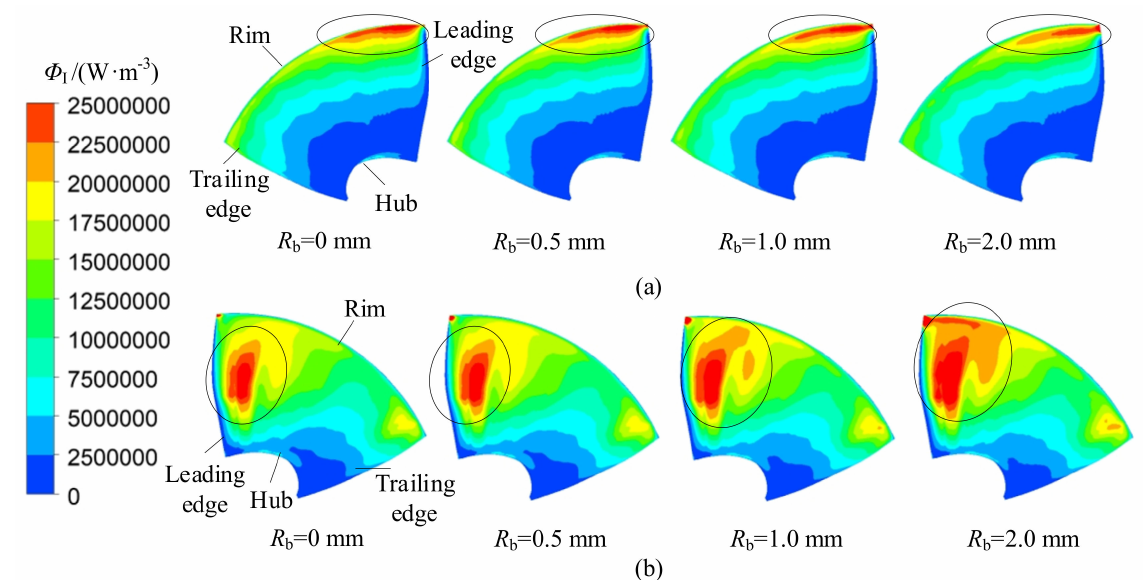
Figure 13. Total dissipation rate distribution on ( a ) pressure side and ( b ) suction side of impeller under different R b at 1.0 Q des .